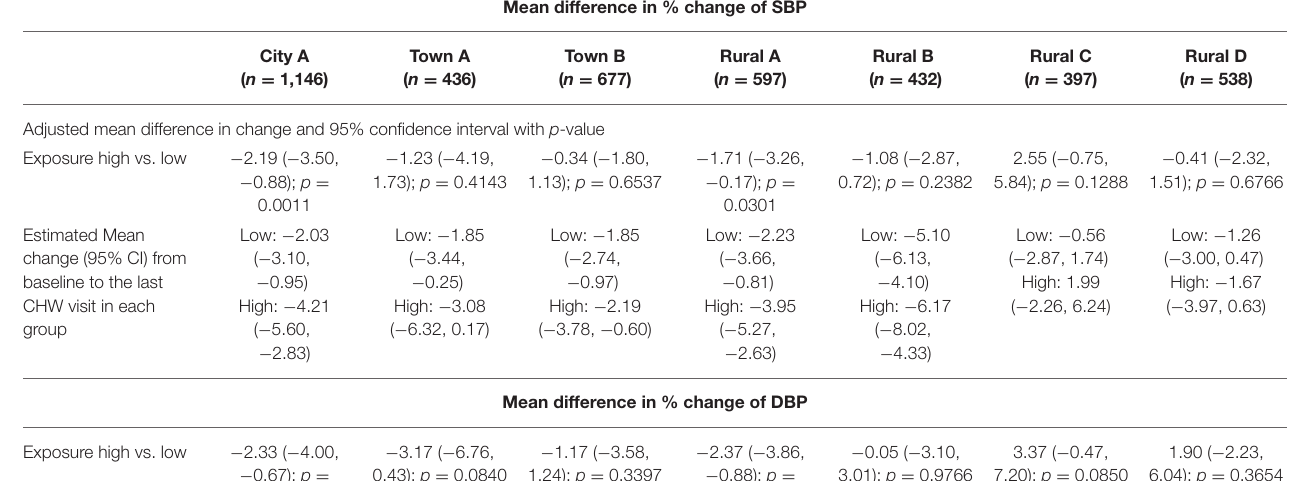
Mean difference in % change of SBP City A Town A Town B Rural A Rural B Rural C Rural D ( n = 1,146) ( n = 436) ( n = 677) ( n = 597) ( n = 432) ( n = 397) ( n = 538)